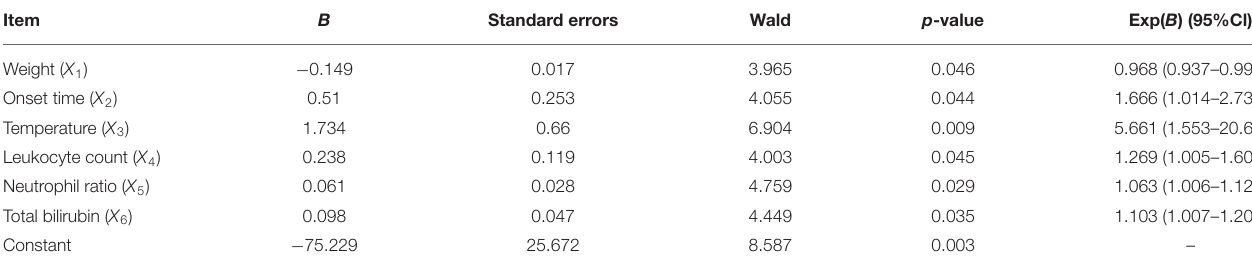
TABLE 3 | Multivariate regression analysis of significant risk